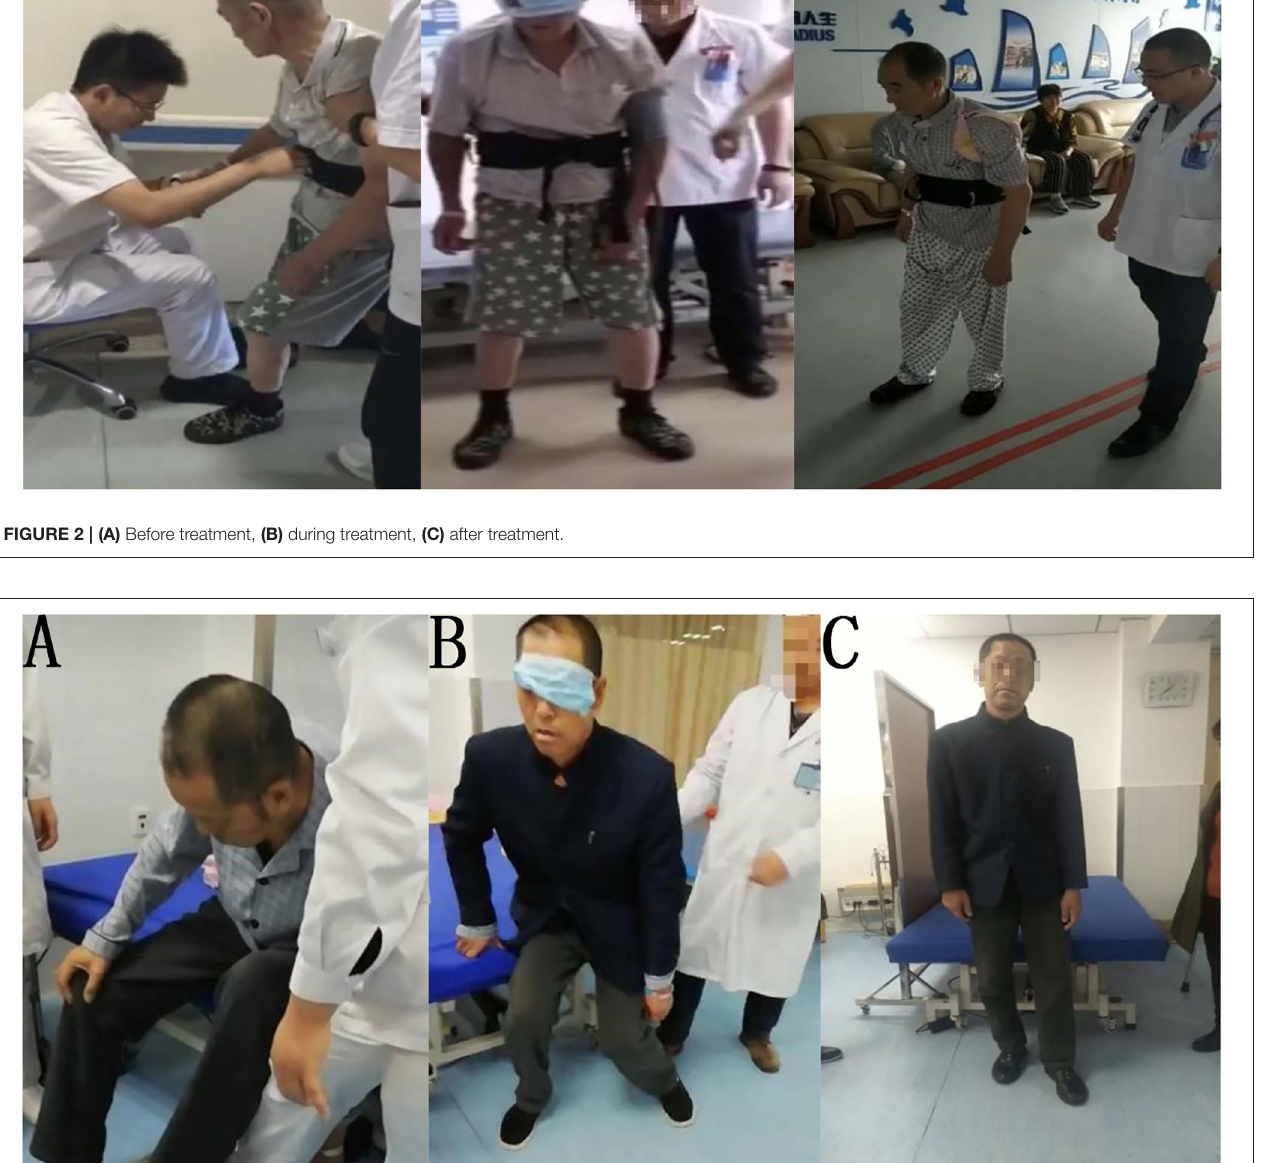
the input of right-sided visuospatial sensory information and promotes the balance of spatial perception on both sides, thus, reducing the excitability of the corresponding brain areas in the left hemisphere and the tendency to pay attention to the right side. This also reduces the excitability of the posterior parietal and motor cortical connections in the left hemisphere, therefore, improving the “pushing phenomenon” and corresponding motor functions in PS